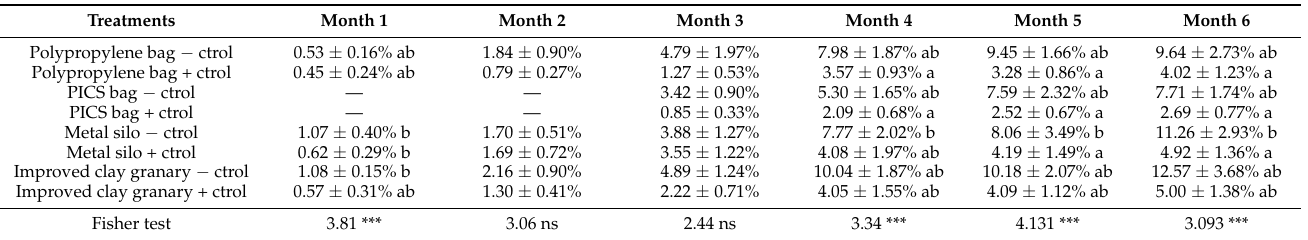
Table 2. Evolution of the average loss rates of the different treatments during storage in Boukoumb é .